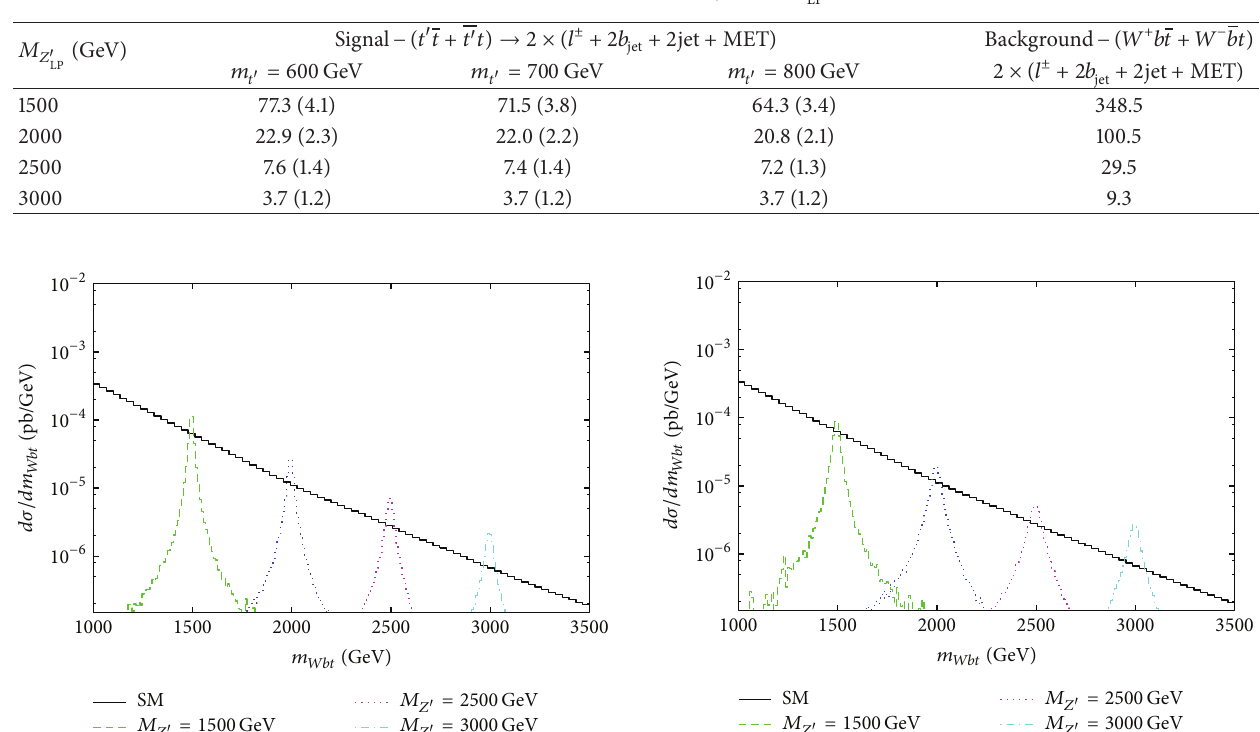
Table 15: The same as Table 12, but for 𝑍 󸀠 LP .